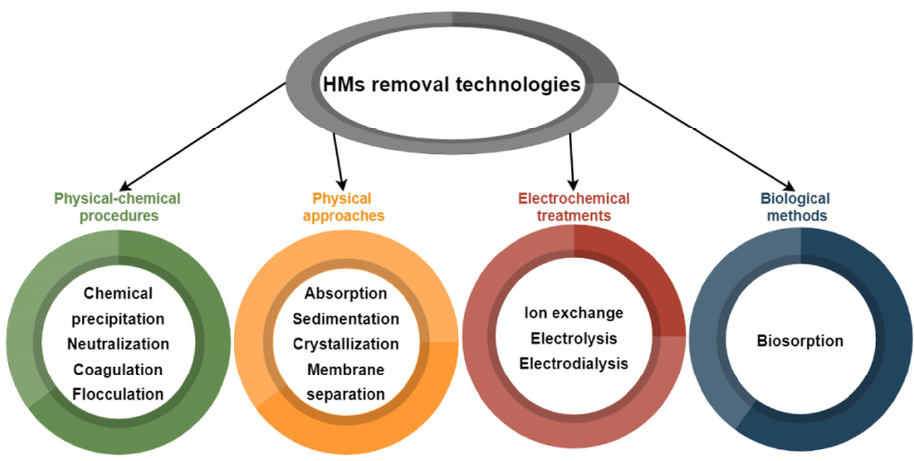
Figure 1. Conventional membrane technologies used for HMs removal from wastewaters.